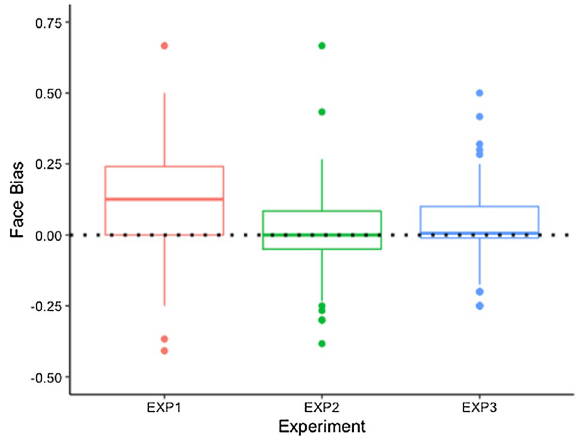
Figure 5. Boxplot to show the average face bias for each experiment. A score of zero (dotted line) indicates the participants judged objects and faces equally. Positive scores indicate a bias towards faces. Boxes show the median and quartiles with outliers represented as dots